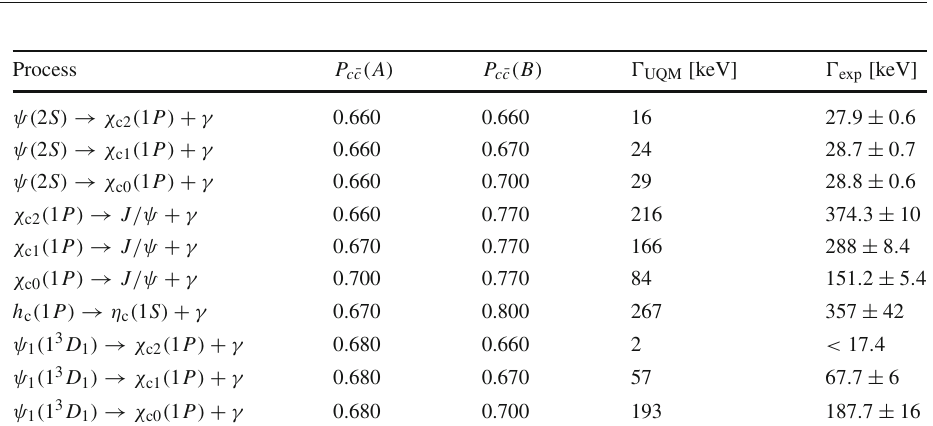
for E 1 radiative decay widths of lower charmonia are compared to the available experimental results